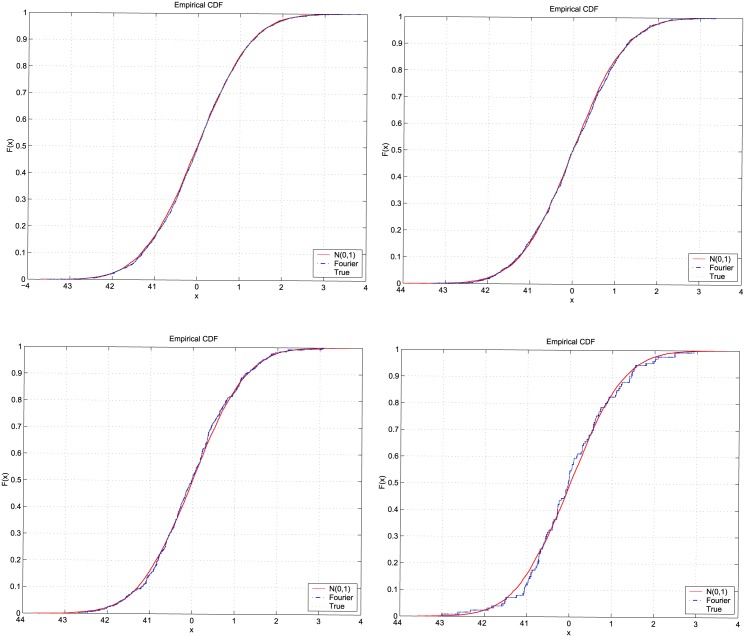
Comparison of cumulative density functions.Cumulative density functions of standard normal sample (red solid line), of the standardized returns obtained using the true volatility (green dotted line) and of the standardized returns obtained using the Fourier spot volatility estimates (blue dash-dot line) when Δ t = 10 seconds (left upper panel), Δ t = 30 seconds (right upper panel), Δ t = 1 minute (left lower panel) and Δ t = 3 minutes (right lower panel).